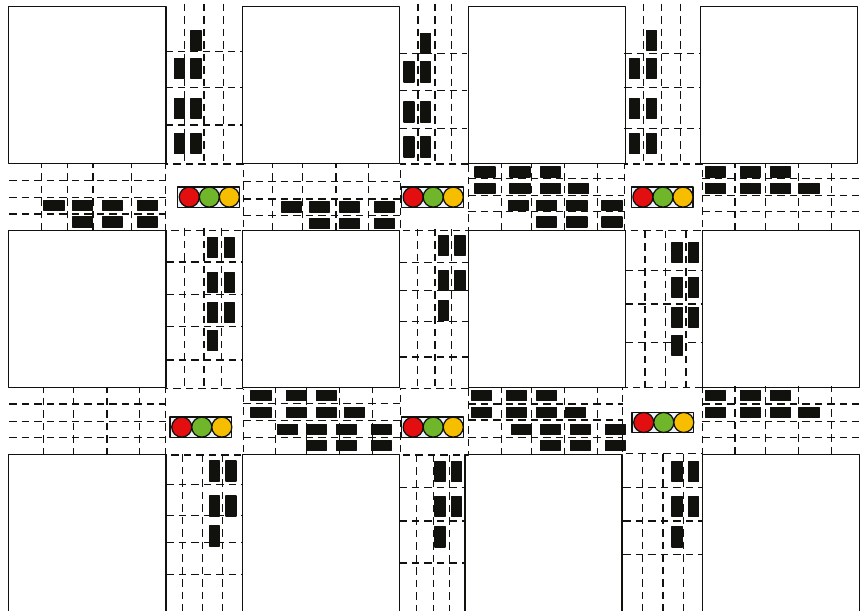
Figure 1: Agent-based tra ffi c model illustration.